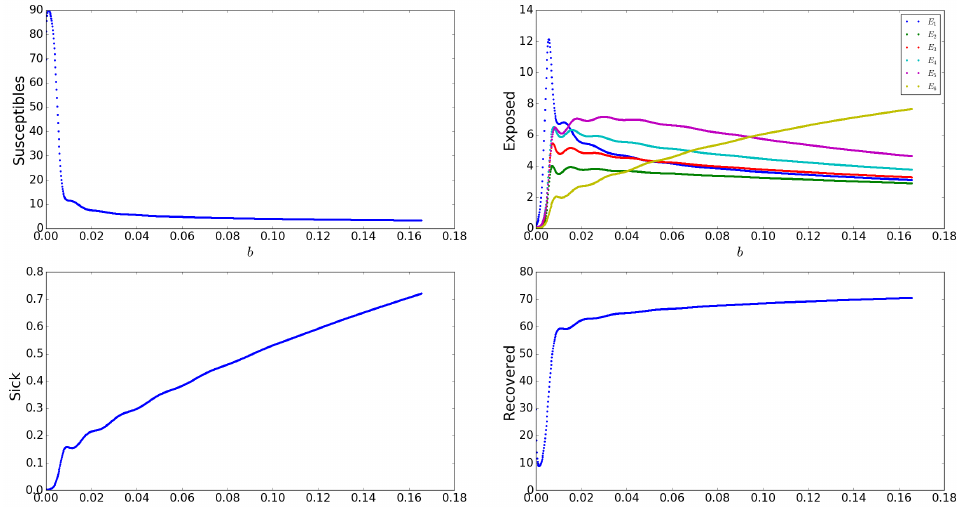
Figure A6. Behaviors of infectious classes relative to b . The horizontal axes scale the parameter b and the vertical axes represent percentage of human populations. The disease fatality (asymptomatic cases) mildly increases as b